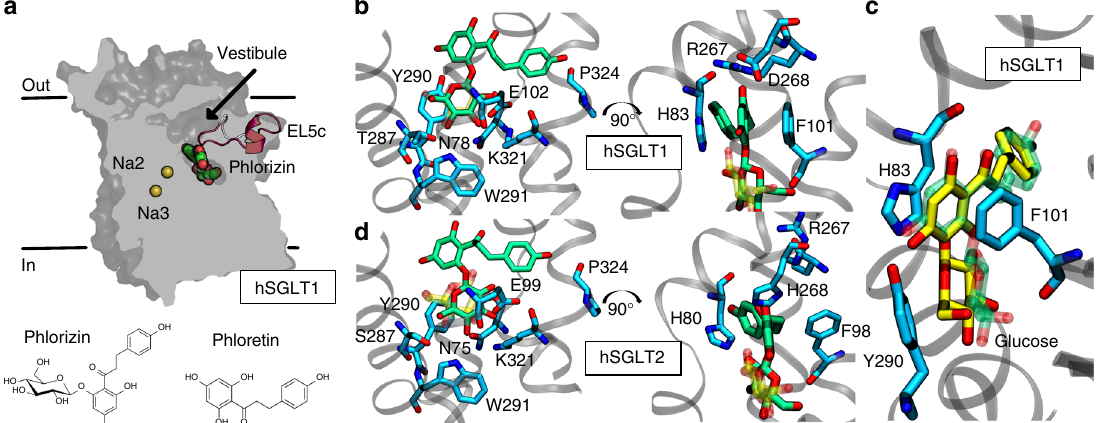
Fig. 1 Predicted binding mode of phlorizin to hSGLT1 and hSGLT2. a Phlorizin bound to the outward-facing hSGLT1. The protein is gray, phlorizin is green and red, and Na + at the putative Na2/Na3 sites are yellow. EL5c (red) is represented as cartoon. The 2D structures of phlorizin and phloretin are also shown. b Close-up view of phlorizin bound to hSGLT1. The sugar moiety occupies the sugar binding site aligning with the docked glucose (transparent yellow/red) where it makes excellent hydrogen bonding with the protein. The aglycon tail creates face-to-face aromatic π – π interactions with H83 and F101 and a cation – π interaction with R267 on EL5 C . c Phloretin and glucose bound to hSGLT1. Phloretin (yellow/red) superposes over the aglycon tail from the phlorizin molecule (transparent green/red) in b , while glucose (yellow/red) aligns well with the sugar moiety. d Close-up view of phlorizin bound to hSGLT2. The binding mode is conserved in hSGLT2, although the aglycon tail is more tightly packed due to an aromatic cage that forms around the central ring made up of residues H80, F98, and H268 on EL5 currents (Fig. 2 and Table 1) elicited by α -methyl- D -glucopyrano- side ( α MDG) — a glucose analog, which we interchangeably refer